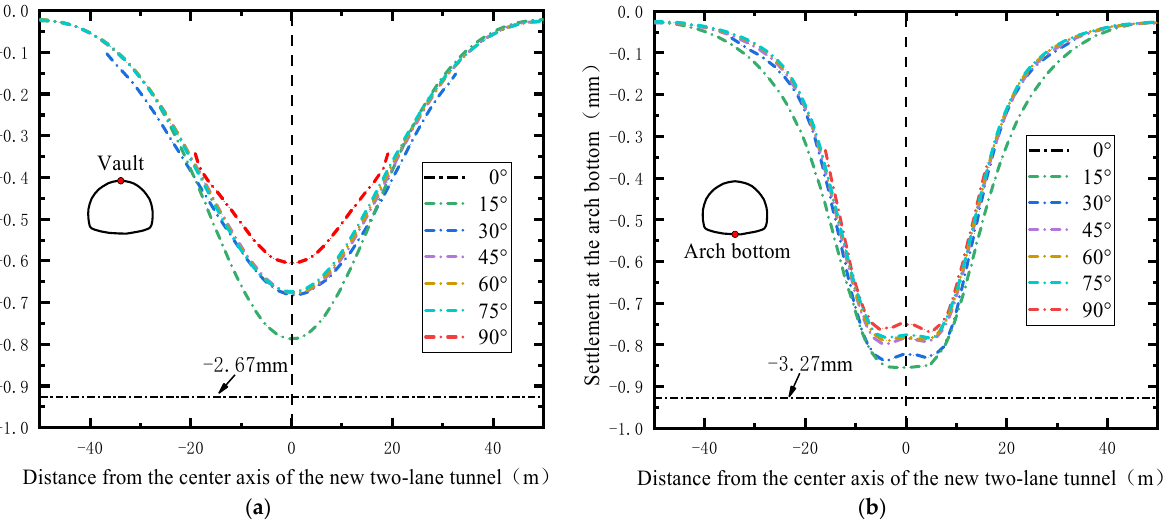
Figure 19. Settlement in an existing tunnel at different spatial intersection angles: ( a ) vault; ( b ) arch bottom.